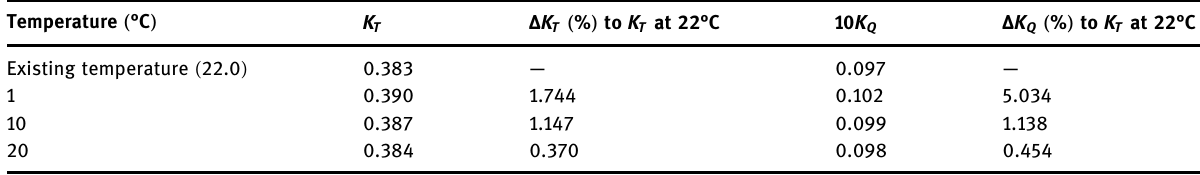
Table 8: Comparison of coe ffi cient of thrust and torque for case 1 J σ 1.019,